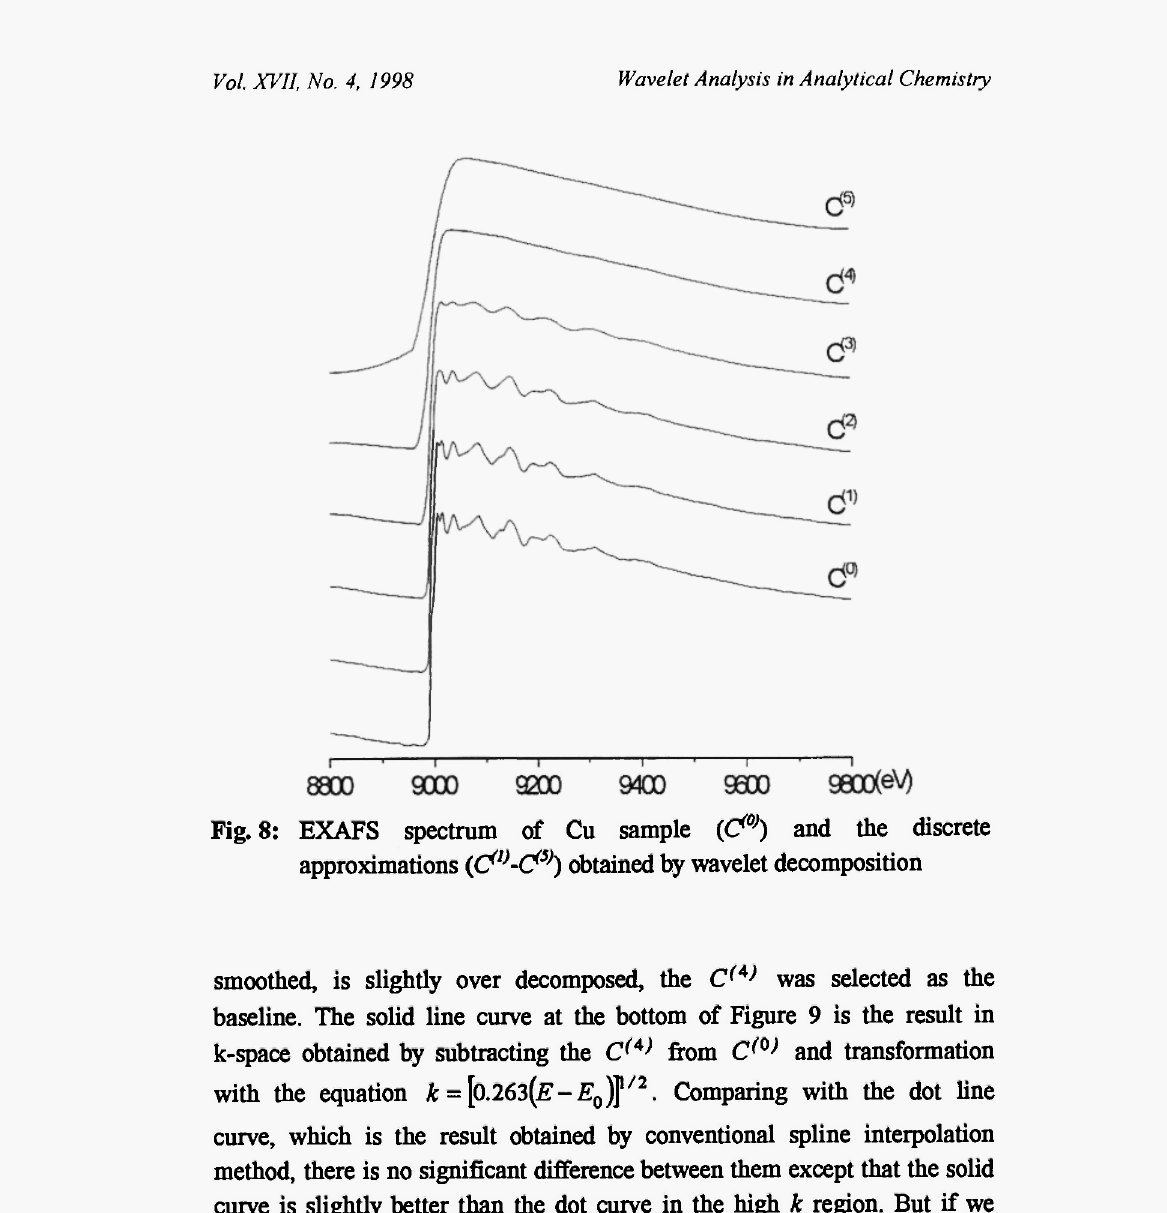
smoothed, is slightly over decomposed, the C (4) was selected as the baseline. The solid line curve at the bottom of Figure 9 is the result in k-space obtained by subtracting the C (4) from C (0) and transformation with the equation k = [O.263(e- E )} /2 . Comparing with the dot 0